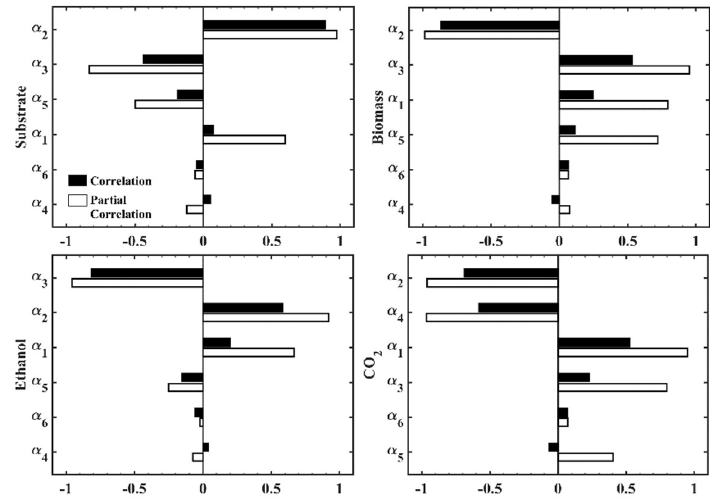
Figure 7. Parametric sensitivity analysis of the proposed model.